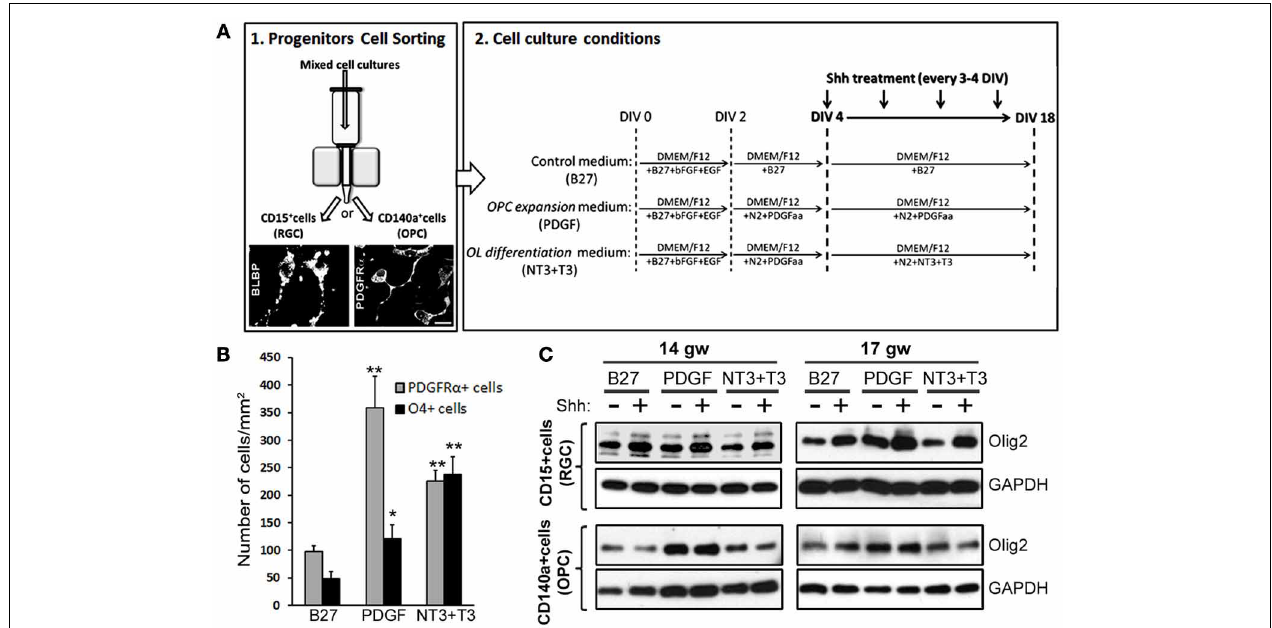
gw RGCs cultures with control (B27), OPC expansion (PDGF) and OLs differentiation (NT3+T3) medium. (C) Protein levels of Olig2 measured by Western blot in RGCs and OPCs cultures with and without Shh treatment in the three different media. The increase levels of Olig2 protein was only observed in RGC cultures, being specially high in OPC expansion medium, and not in OPC cultures; GAPDH-loading control. Data are presented as